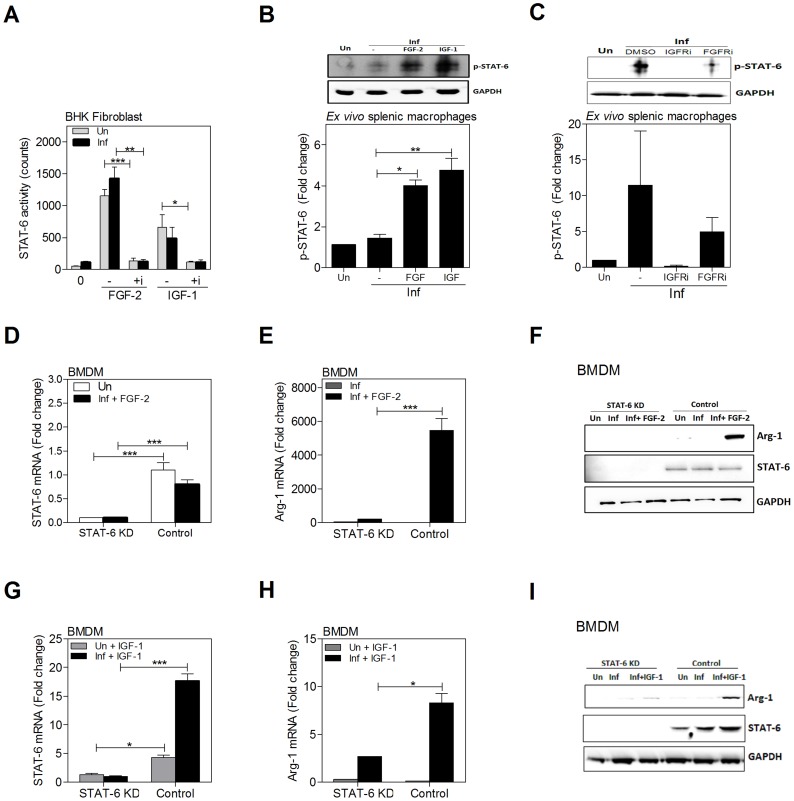
Growth factors and cytokines converge at STAT6 to induce arg1 expression in L. donovani infected macrophages.
A) Growth factors activate STAT6. Hamster BHK fibroblasts transfected with a STAT6 luciferase reporter were uninfected (Un) or infected (Inf) with L. donovani and stimulated for 24 h with FGF-2 (20 ng/mL) or IGF-1 (100 ng/mL) in the absence or presence (+i) of 250 nM of an inhibitor of FGFR-1 (PD166866) or IGF-1R (PPP). Shown is the mean and SEM of luciferase activity from 3 replicates from a single experiment that was representative of 2 independent experiments. B) phospho-STAT6 expression in BMDMs stimulated with IGF-1 and FGF-2. BMDMs were uninfected (Un) or infected in vitro with L. donovani (Inf) and stimulated or not with FGF-2 (20 ng/mL) or IGF-1 (100 ng/mL) for 20 min. STAT6 protein was immunoprecipitated in cell lysates and phosphorylated STAT6 determined by immunoblot. GAPDH was used to confirm that equivalent amounts of protein were subjected to the immunoprecipitation. Bars represent the mean and SEM of fold change with reference to the uninfected controls calculated by densitometry analysis of immunoblot bands from 6 independent experiments. Also shown is a representative individual immunoblot. C) Blockade of STAT6 activation by IGF-1R and FGFR inhibitors. Splenic macrophages from uninfected hamsters were pre-treated with IGF-1R inhibitor (100 nM PPP) or FGFR inhibitor (300 nM PD166866) and infected in vitro with L. donovani for 20 min in absence of the inhibitor. STAT6 protein was immunoprecipitated in cell lysates and the level of phosphorylated STAT6 determined by immunoblot. Data shown is from 3 independent experiments, with a representative individual immunoblot, as described for Fig. 8B. D) Expression of STAT6 mRNA in BMDMs that were uninfected-unstimulated (Un), infected (Inf), or infected and stimulated with FGF-2 after transfection with STAT6-specific siRNA (STAT6 KD) or scrambled siRNA (Control). Shown is the mean and SEM of the fold-increase in STAT6 mRNA with reference to uninfected control as determined by qRT-PCR in 4–10 replicates from a single experiment that was representative of 3 independent experiments. E) Abrogation of arg1 mRNA expression by knockdown of STAT6 in BMDMs infected in vitro with L. donovani and stimulated with FGF-2. BMDMs were transfected with the siRNA as described above and then infected and stimulated with FGF-2 (20 ng/mL) for 24 hrs. The data are shown as the mean and SEM of the fold-increase in arg1 mRNA relative to negative (uninfected) control cells from a single experiment that was representative of 3 independent experiments. F) Immunoblot showing efficiency of siRNAi-mediated knockdown of STAT6 protein in hamster BMDMs and the requirement of STAT6 in the FGF-2-induced arg1 expression in L. donovani infected cells. Following transfection with the STAT6-specific (STAT6 KD) or control siRNAi the BMDMs were uninfected (Un), infected with L. donovani (Inf), or infected and treated with FGF-2 (20 ng/mL) for 48 hrs. G) Expression of STAT6 mRNA in BMDMs that were uninfected and stimulated with IGF-1 (200 ng/mL) or infected (Inf) and stimulated with IGF-1 after transfection with STAT6-specific siRNA (STAT6 KD) or scrambled siRNA (Control). Shown is the mean and SEM of the fold-increase in STAT6 mRNA compared to IGF-1-treated STAT6 KD cells as determined by qRT-PCR in 3 replicates from a single experiment that was representative of 2 independent experiments. H) Abrogation of arg1 mRNA expression by knockdown of STAT6 in BMDMs infected in vitro with L. donovani and stimulated with IGF-1. BMDMs were transfected with the siRNA as described above and then infected and stimulated with IGF-1 (200 ng/mL) for 24 hrs. The data are shown as the mean and SEM of the fold-increase in arg1 mRNA as determined by qRT-PCR relative to nonstimulated cells from a single experiment that was representative of 2 independent experiments. I) Immunoblot showing efficiency of siRNAi-mediated knockdown of STAT6 protein in hamster BMDMs and the partial requirement of STAT6 in the IGF-1-induced arg1 expression in L. donovani infected cells. Experiment was designed and data presented as described for Fig. 8F. IGF-1 was used at 200 ng/mL. Shown is an immunoblot from a single experiment that was representative of 2 independent experiments. *p<0.05; **p<0.01; ***p<0.001.